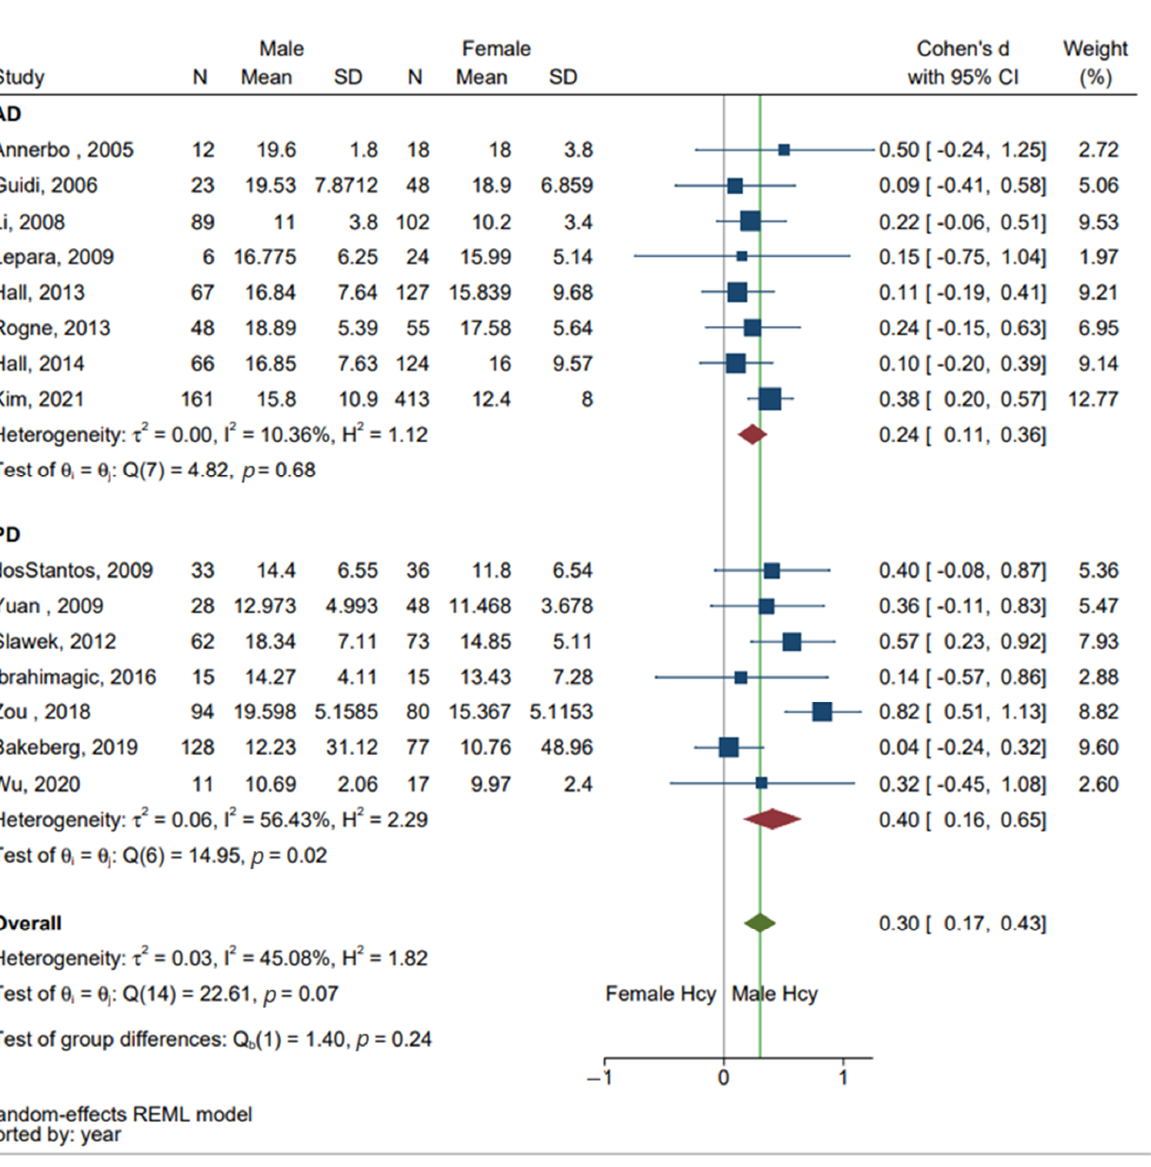
Hcy levels from males are featured in positive values and Hcy levels from females are featured in negative values. The square symbols ( (cid:4) ) represent the SMD in each study, with the size of the symbol being proportional to the precision of the estimate and the error bars indicating the 95% CI. The red diamond symbol ( (cid:7) ) is the estimated overall effect for each disease and the green diamond symbol ( (cid:7) ), the overall effect for both AD and